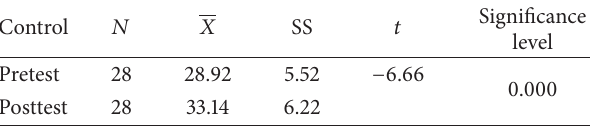
Table 4: Dependent groups 𝑡 -test results related to the pre- and posttest scores of the control group.